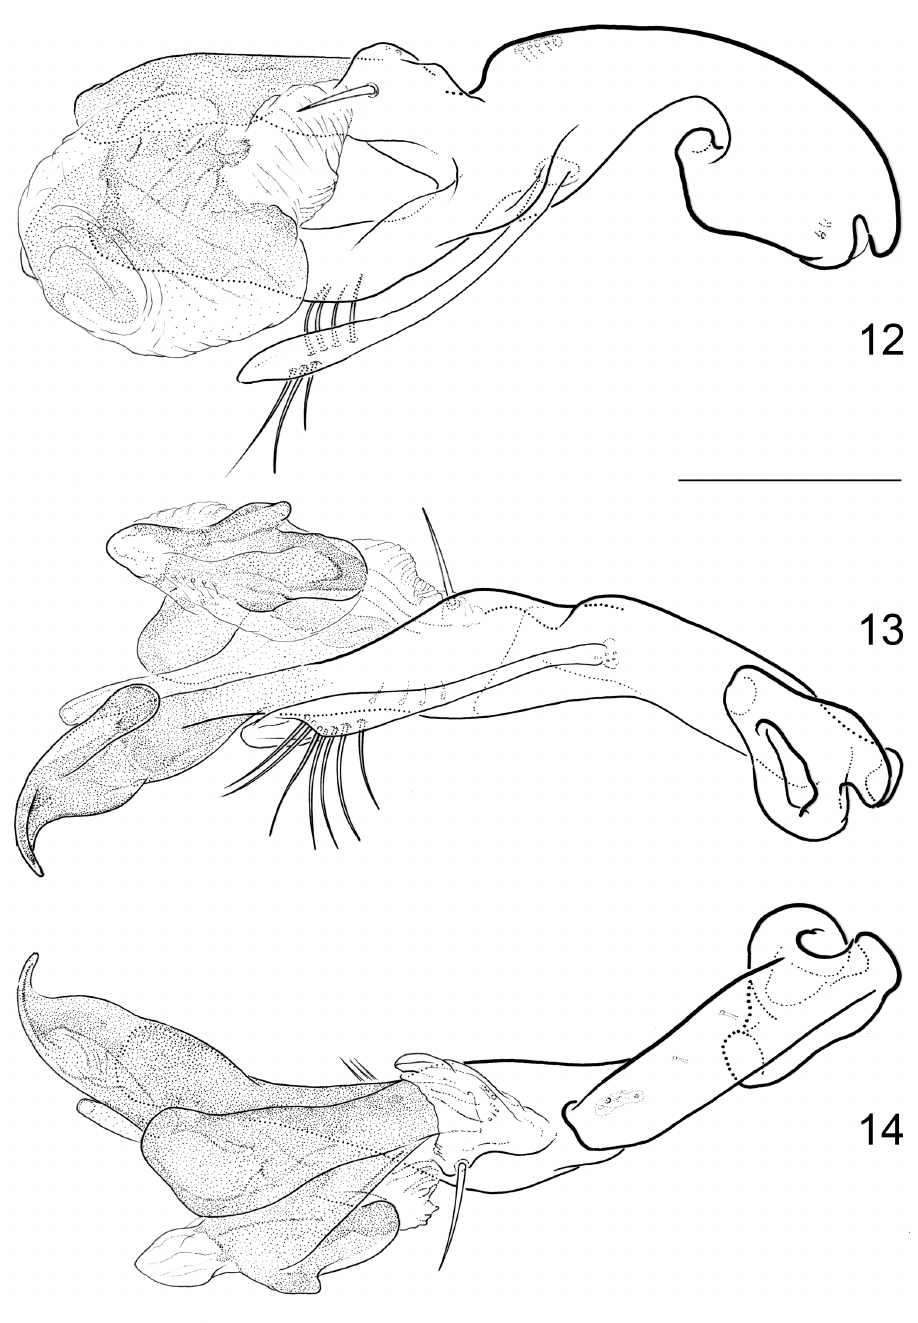
Figures 12–14. Hydraena matyoti Jäch & Delgado, sp. n., aedeagus: 12 lateral view 13 ventral view 14 dorsal view. Scale bar: 0.1